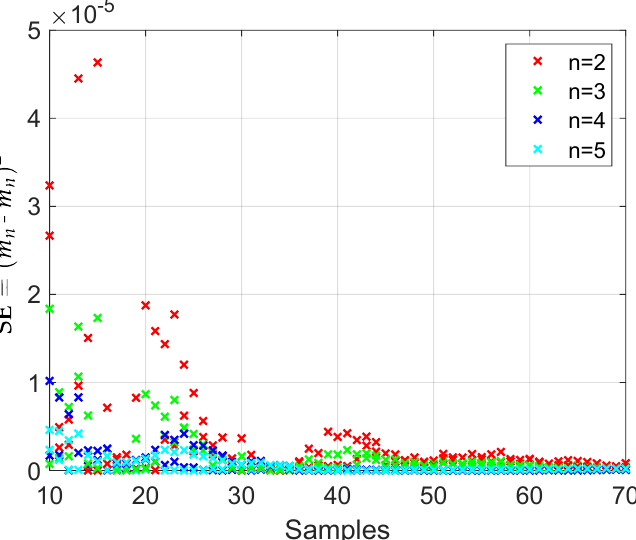
Figure 2. SE of the first 4 simulated moments ( ˜ m n ) from the exact moments ( m n ) with M = L =